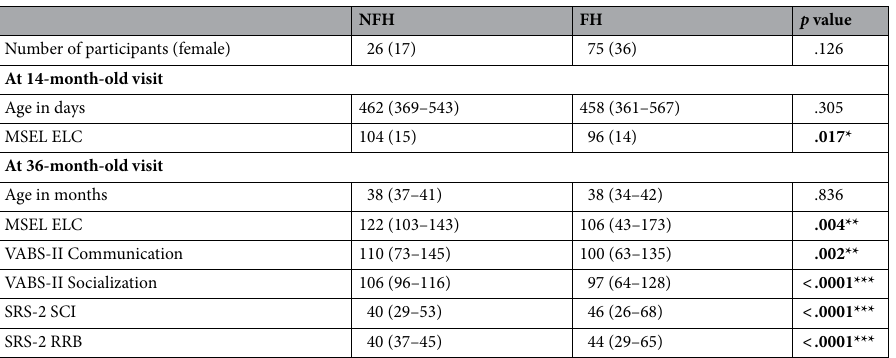
Table 1. Demographics of the sample for comparisons between the social and non-social condition. Medians with the lower and upper quartile boundaries in parentheses are given for all measures at the 14 and 36-month-old visits, except for MSEL ELC scores at the 14-month-old visit for which the mean and standard deviation in parentheses are given. Significant comparisons (at the α level = .05) are printed in bold. MSEL ELC—Mullen Scale for Early Learning Early Learning Composite Standard Score; SRS-2 RRB—Social Responsiveness Scale-2, T-score for the Restricted and Repetitive Behaviours domain; SRS-2 SCI—Social Responsiveness Scale-2, T-score for the Social Communication and Interaction domain; VABS-II Communication—Vineland Adaptive Behaviour Scale-II, Communication domain standard score; and VABS-II Socialization—Vineland Adaptive Behaviour Scale-II, Socialization domain standard